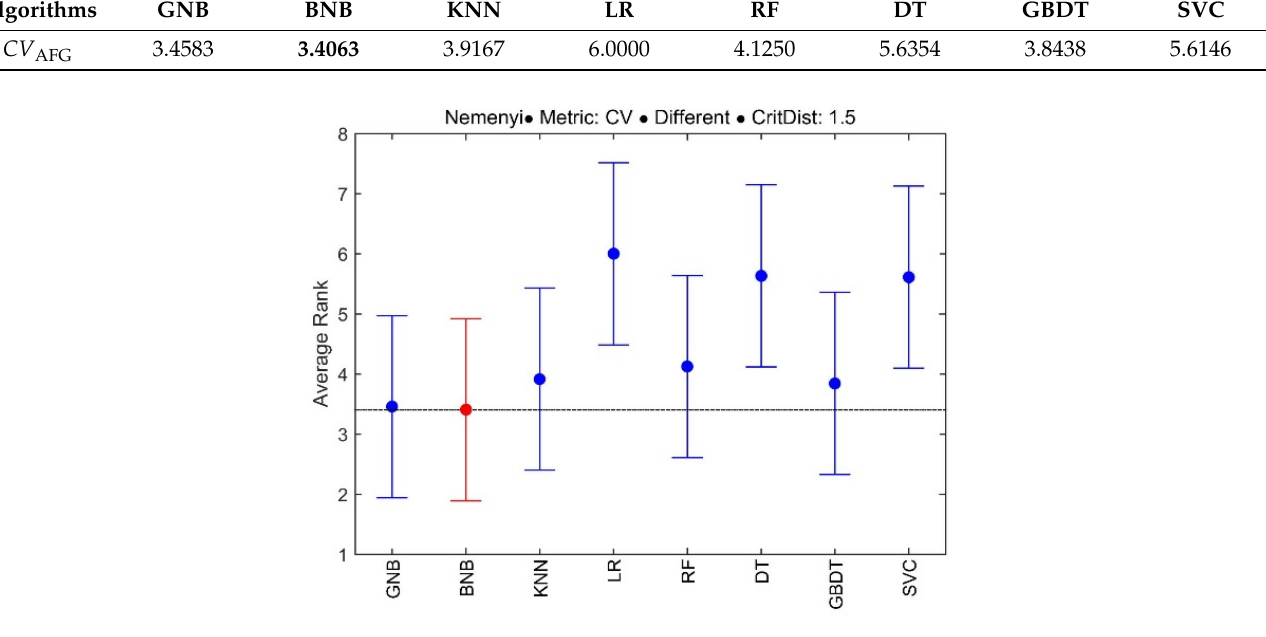
Figure 10. Result of the Nemenyi post hoc test.